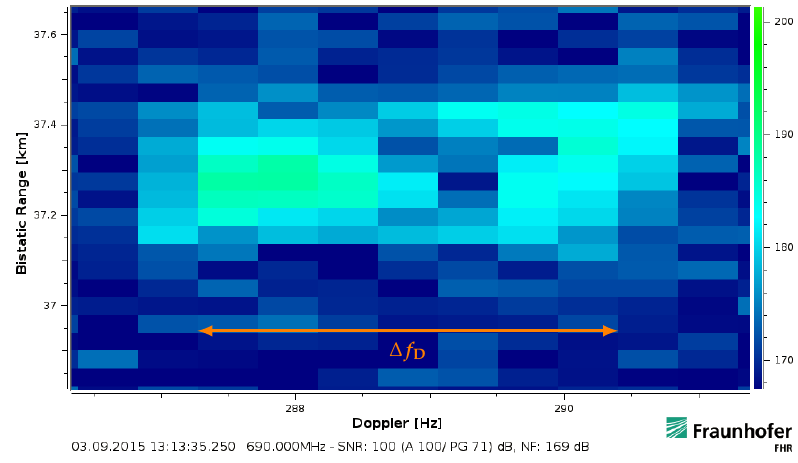
Figure 12. Fluctuating return of the previously shown approaching target with v ≈ 225km/h, shortly after Figure 11 with a deviated target return in B eff = 7.61MHz over T int = 1.79s and T cov = 2.24s. By using Equations (14) and (17), the Doppler frequency difference ∆ f D = f D ( f u )